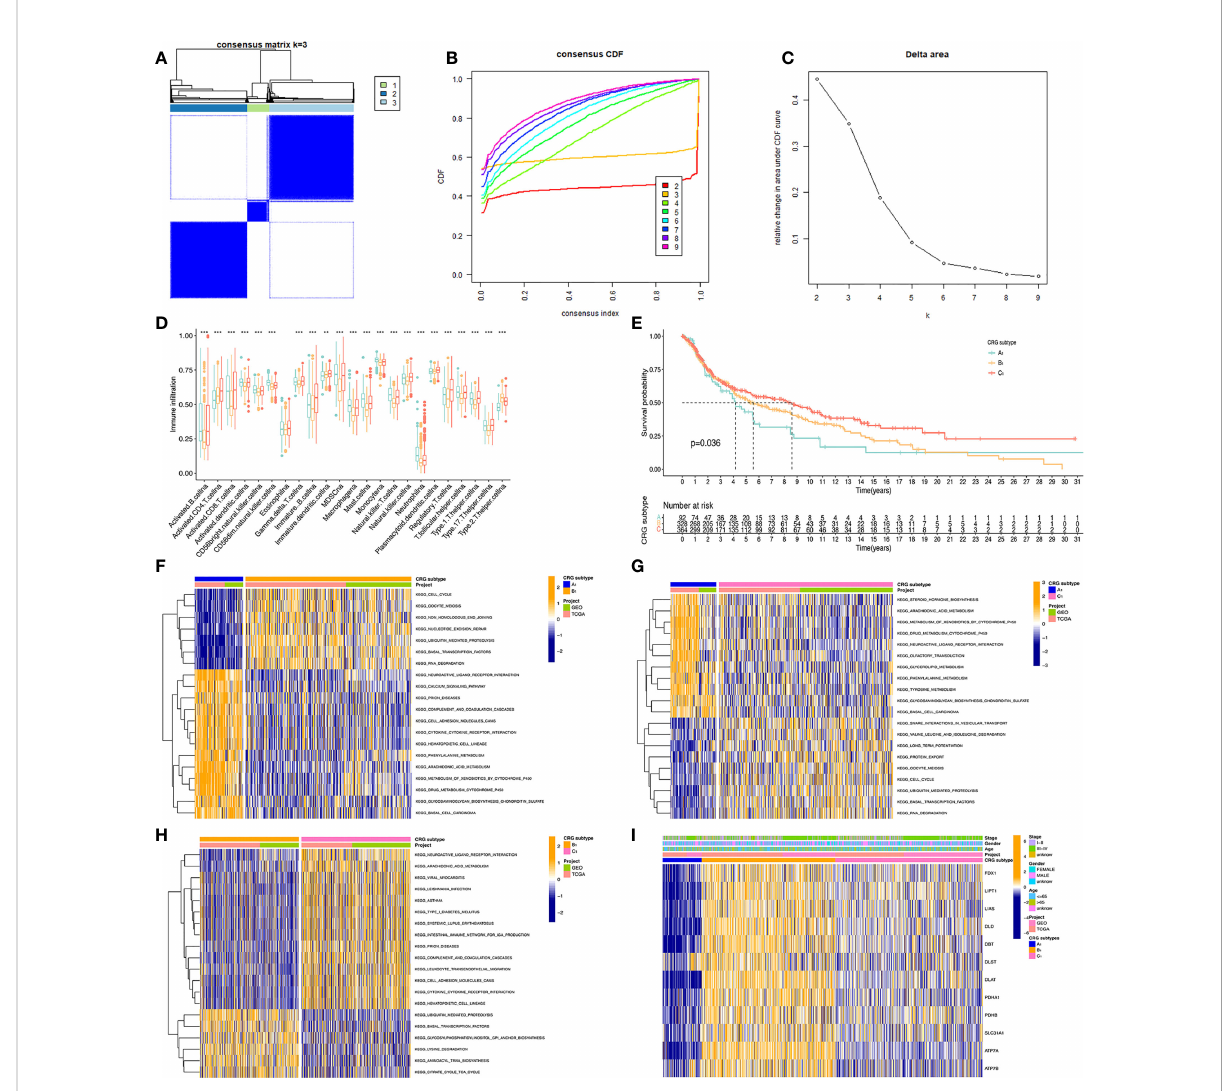
FIGURE 2 Classi fi cation of melanoma based on CRGs. (A) Molecular subtypes based on CRGs obtained under unsupervised consensus clustering. (B) The empirical cumulative distribution function (CDF) plot depicts the consistent distribution of different K values. (C) Relative increase in cluster stability by delta area fraction. (D) Comparison of the degree of immune cell in fi ltration of the three molecular subtypes*, P<0.05; **, P<0.01; ***, P<0.001. (E) Kaplan Meier analysis results of three molecular subtypes based on 12 CRGs. (F, G, H) pictures show the enriched pathways of differentially expressed genes obtained by comparing A 1 , B 1 , and C 1 molecular subtypes with each other using the GSVA method. (I) Heatmap of clinical information and gene expression pro fi les of the three molecular subtypes based on 12